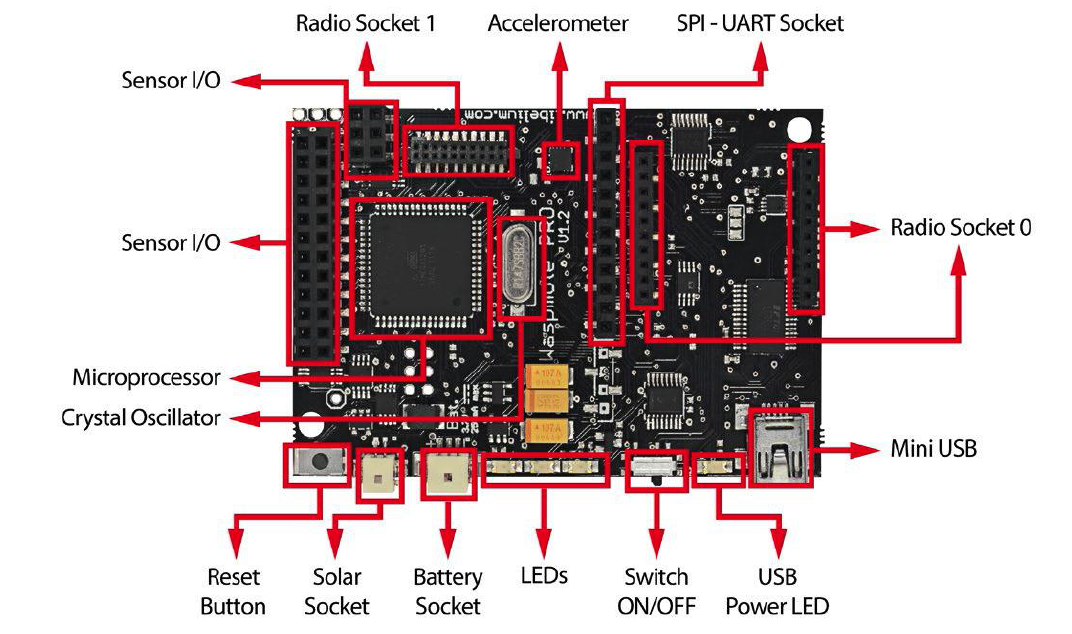
Figure 3. Anatomy of the Waspmote